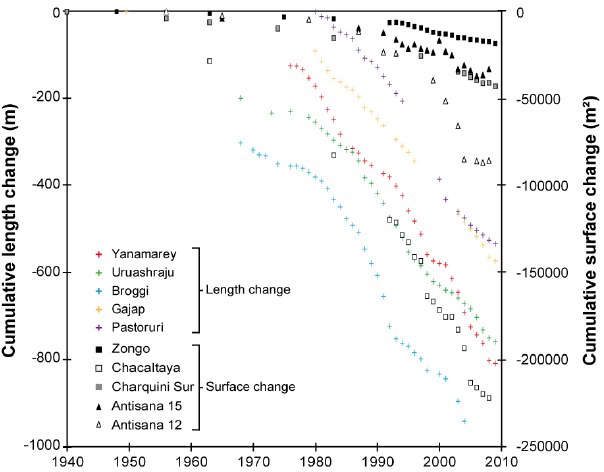
Fig. 5. Changes in surface area of five glaciers in Ecuador and Bolivia, and in length for five Peruvian glaciers. Observations of changes in length start in 1949 except for Pastoruri Glacier (1980). Observations in changes in surface area start in 1940 in Bolivia and 1956 in